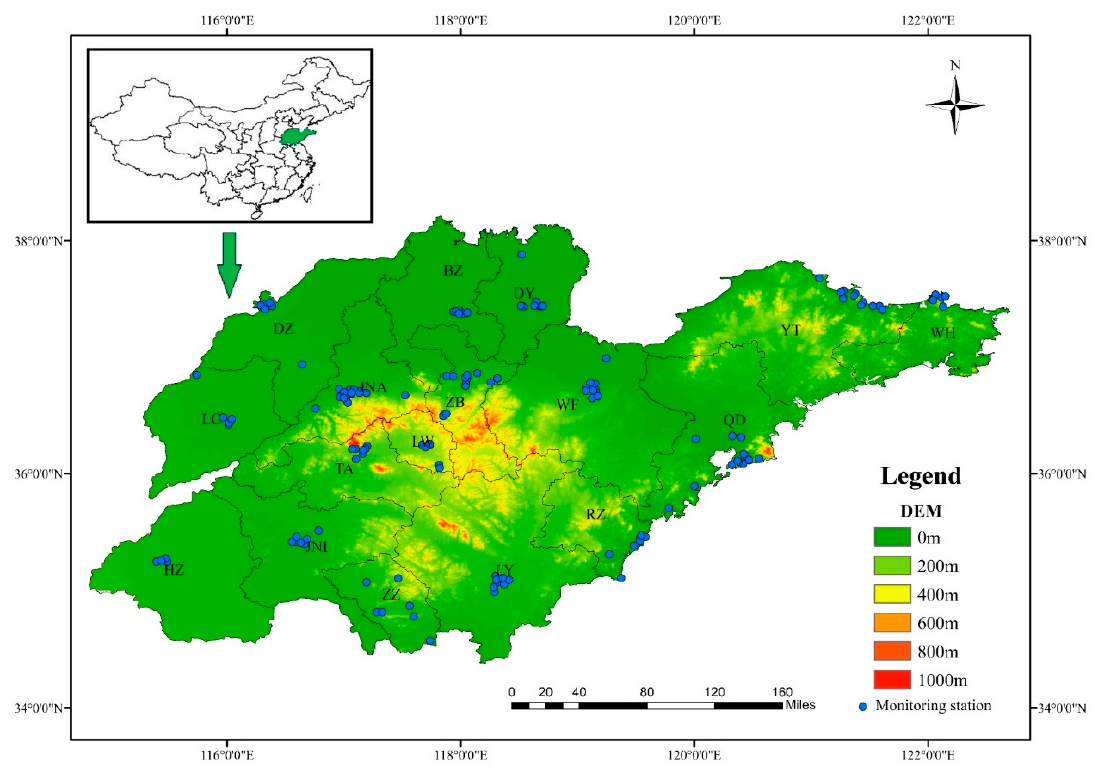
Figure 1. Study Area of Shandong province, including 17 Prefectural level cities until 2018. A total of 154 national and provincial environmental air quality monitoring stations are labeled in the figure. The bold black line indicates the boundary of Shandong province, and the gray line indicates the city boundary.